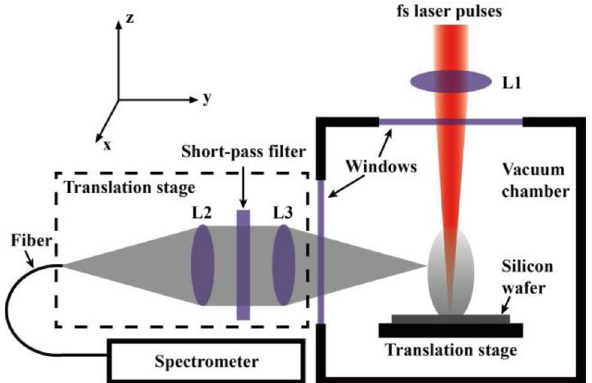
Figure 1. Schematic of the experimental setup.